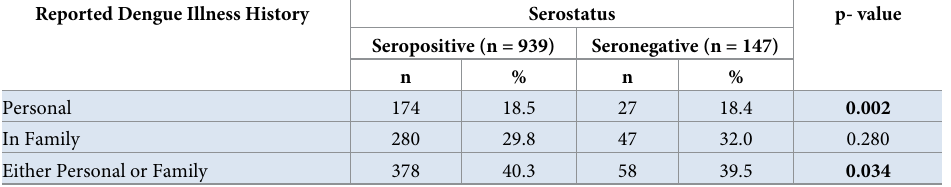
Table 1. Correlation between Reported Dengue Illness History and Cohort seropositive and seronegative